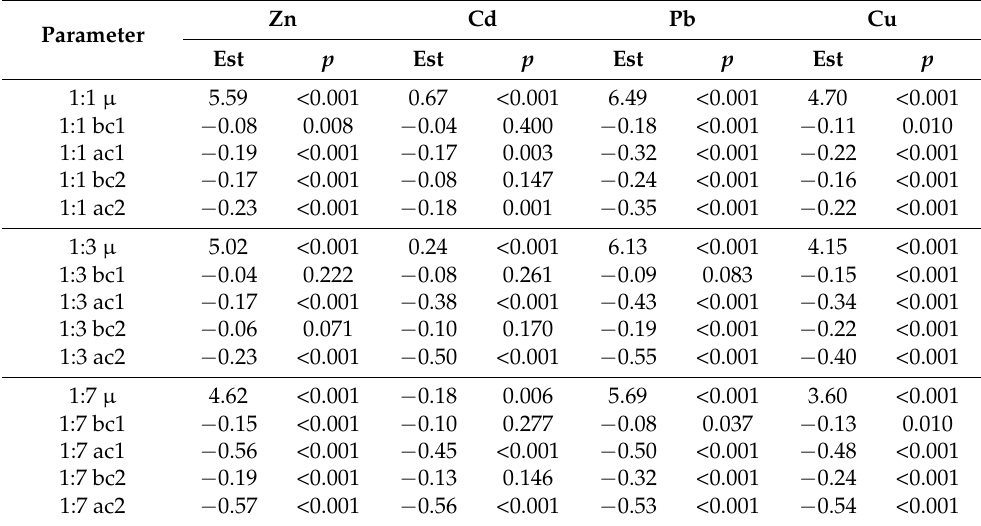
Table 6. GLM model parameters describing the influence of applied carbon doses on metal form concentration after DTPA extraction for a given soil combination.